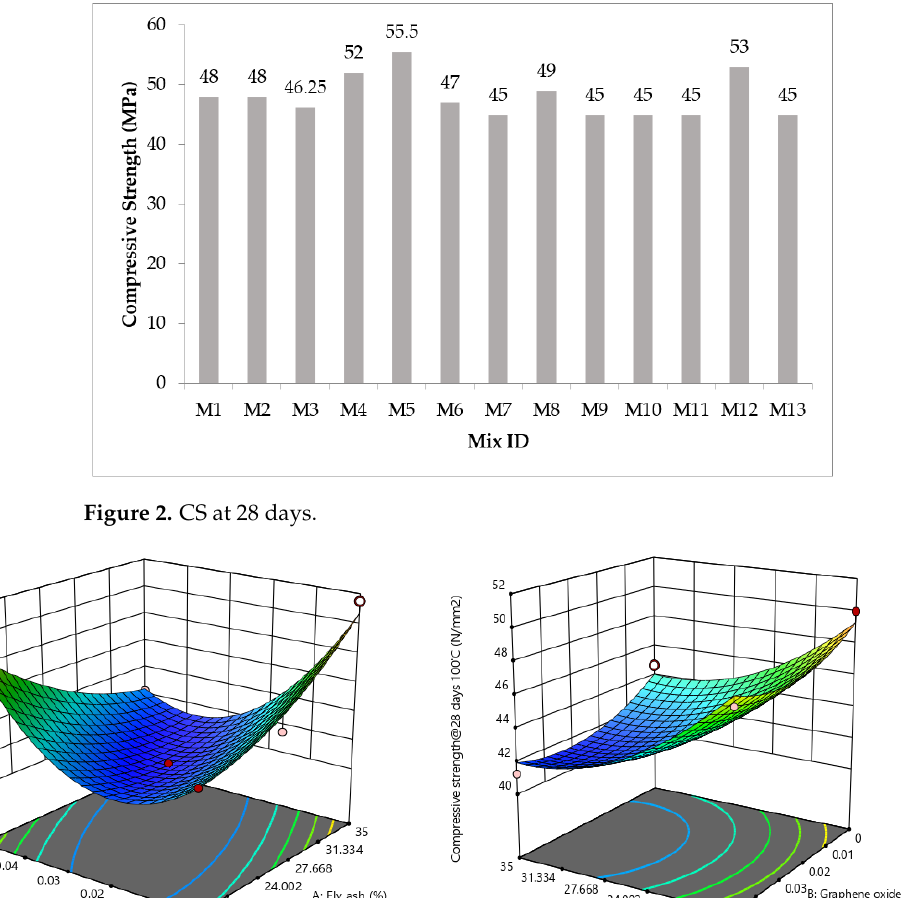
graphene oxide, respectively, in percentage (%).